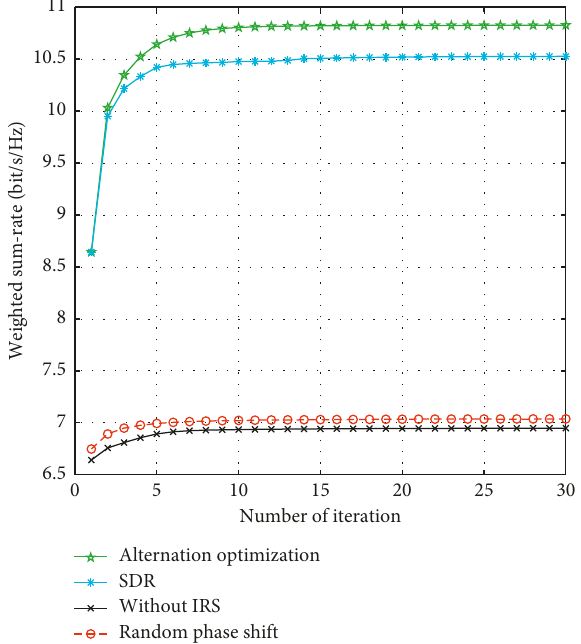
Figure 8: Change curve of the achievable rate with the number of